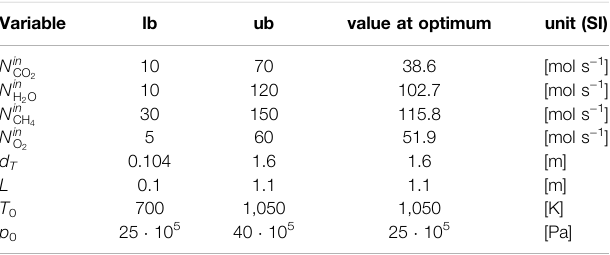
TABLE2| Listofrelevantoptimizationvariablesfordesignproblems,bounds,and results for TRI. Variable